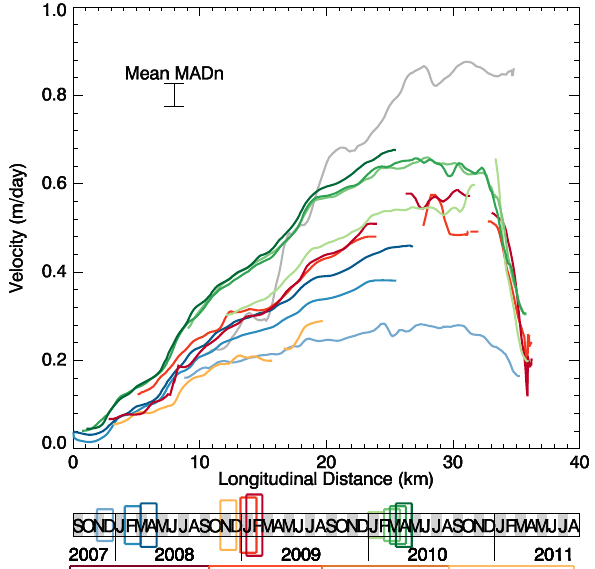
Fig. 4. West Bagley longitudinal velocity profile (location in Fig. 1). Dates of each image pair are denoted in the timeline below as in Fig. 2. Colors gradually darken as time moves forward each win- ter. The grey data line shows WB velocities in January 1994. Note scales are different than Fig.